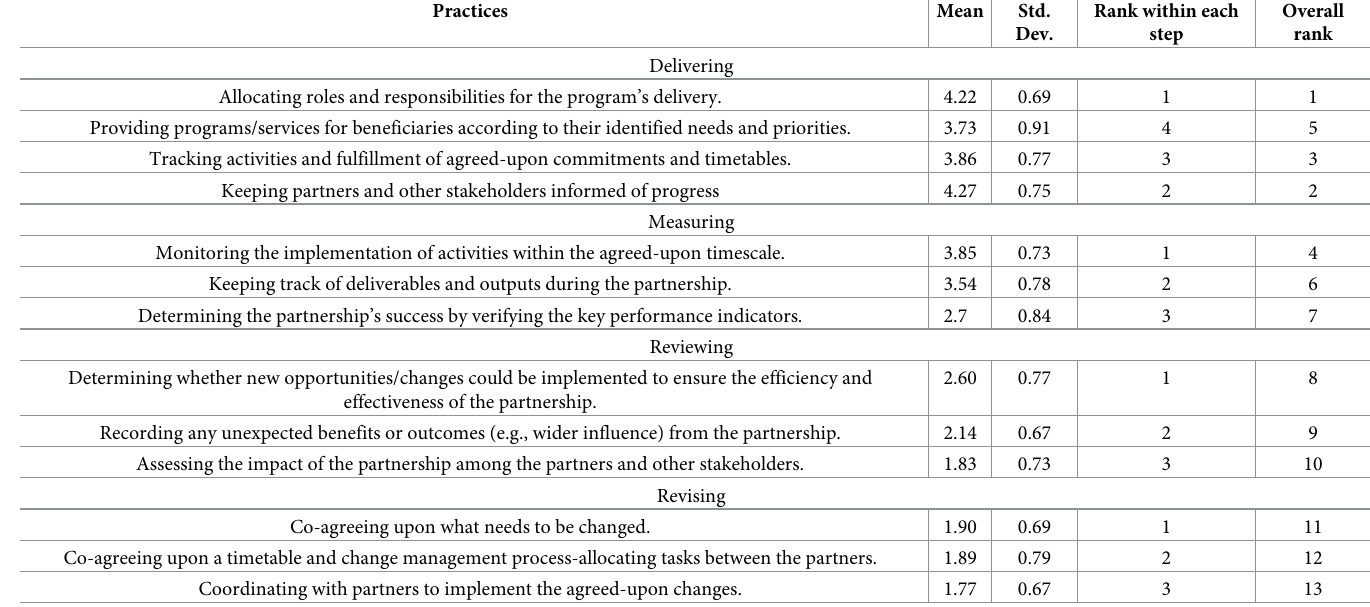
Table 4. Descriptive results of reviewing and revising the practices followed by nonprofit organizations.